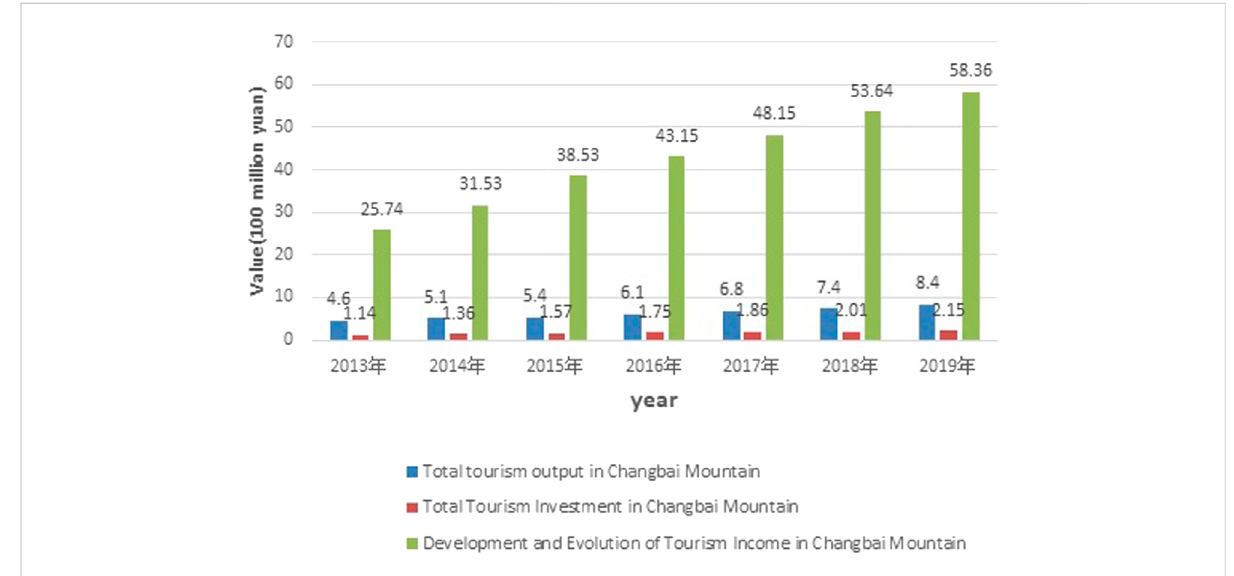
Total tourism output and income in Changbai